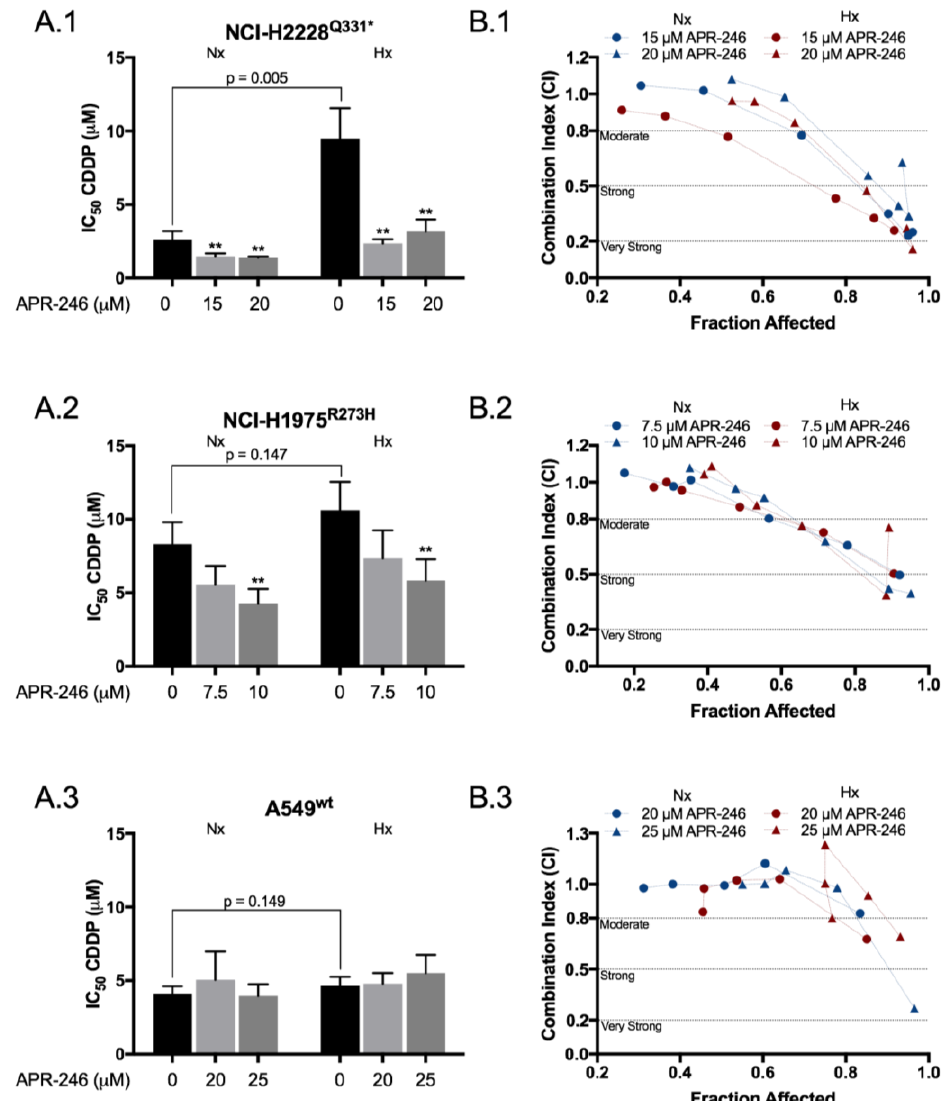
Figure 1. APR-246 synergistically enhanced the cytotoxic effect of CDDP in a p53-mutant background under both normoxic and hypoxic conditions. ( A1 – A3 ) To determine possible synergism, cells were simultaneously treated for 72 h with a CDDP (cisplatin) dose range of 0, 0.5, 1, 2, 5, 10 μM (A549 wt ) or 0, 0.5, 1, 2, 5, 10, 20 μM (NCI-H2228 Q331 * and NCI-H1975 R273H ) and fixed concentrations of APR-246, based on the drug sensitivity of each cell line (Table S1). Cell confluence was determined using the SRB-assay and IC 50 values were calculated using WinNonlin. IC 50 values for CDDP monotherapy or combined with APR-246 are presented as mean ± SD of at least 3 independent experiments. ( B1 – B3 ) The corresponding combination index was calculated using the ‘Additive Model’ for each concentration presented, in correlation with the affected fraction (FA) of the cells. CI = 1.0 ± 0.2 indicates an additive effect, <0.8 indicates moderate synergism, <0.5 strong synergism, and <0.2 very strong synergism (** p < 0.05 compared to CDDP monotherapy). The corresponding values are presented in Table S1. Nx: normoxia; Hx: hypoxia.